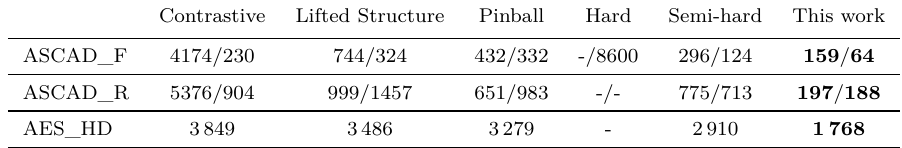
Table 9: Benchmark different loss functions with T GE 0 . Attack results for the HW and ID leakage models are separated by ’/’.